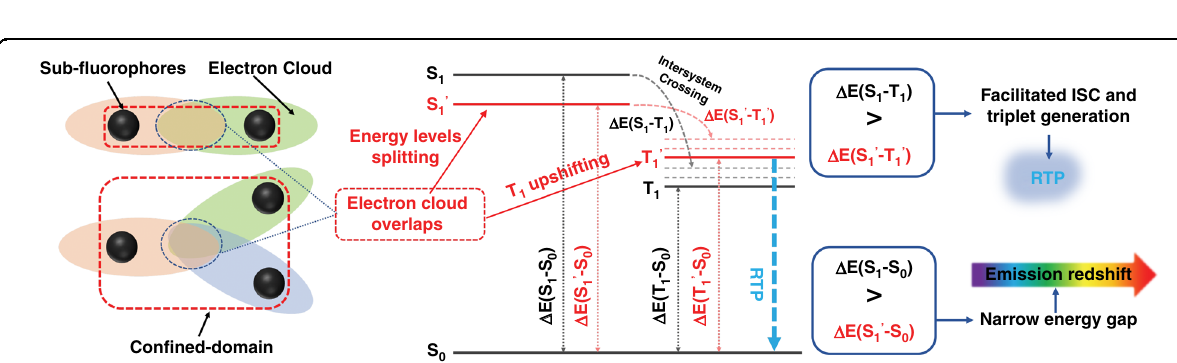
Fig. 2 Schematic showing the con fi ned-domain cross-link-enhanced emission effect. The overlap and couple of electron clouds caused by con fi ned-domain split intrinsic energy levels to sub-levels and upshift the triplet states energy level. This results in PL emission redshift and RTP generation. (S 0 : Ground singlet state, S 1 : The original excited singlet state, T 1 : The original excited triplet states, S 1 : The formed excited singlet state from energy levels splitting, T 1 ′ : The formed excited triplet state from T 1 upshifting, Δ E(S 1 – S 0 ): The original energy gap between S 0 and S 1 , Δ E(S 1 ′ – S 0 ): Energy gap after con fi ned-domain cross-link between S 0 and S 1 ′ , Δ E(S 1 – T 1 ): The original energy gap between S 1 and T 1 , Δ E(S 1 ′ – T 1 ′ ): Energy gap after con fi ned-domain cross-link between S 1 ′ and T 1 ′